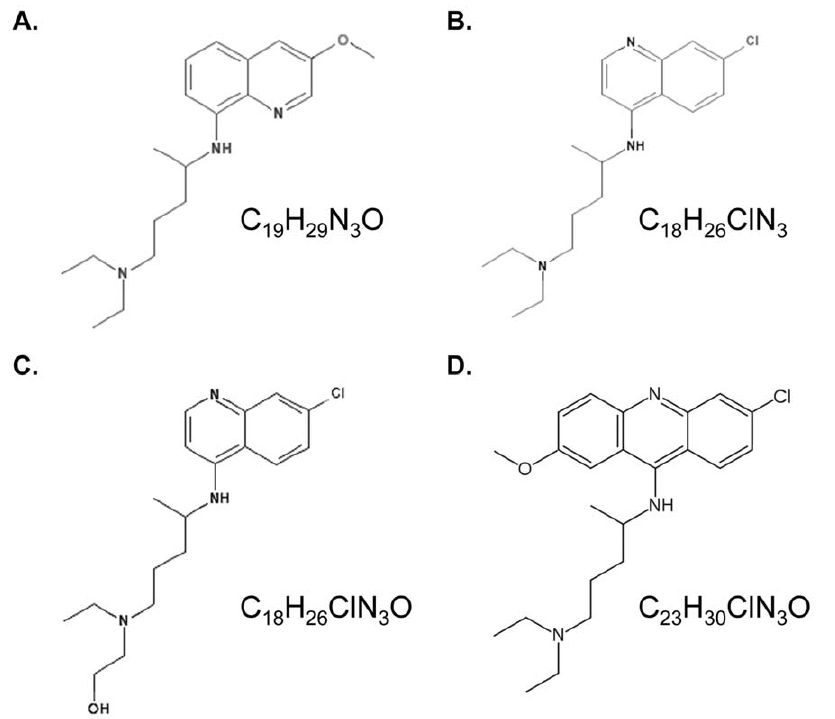
Figure 2. Chemical structures of the NCI compound and structurally similar anti-malarial drugs used in this study. (A) NCI compound NSC56612, (B) chloroquine, (C) hydroxychloroquine, and (D) quinacrine.